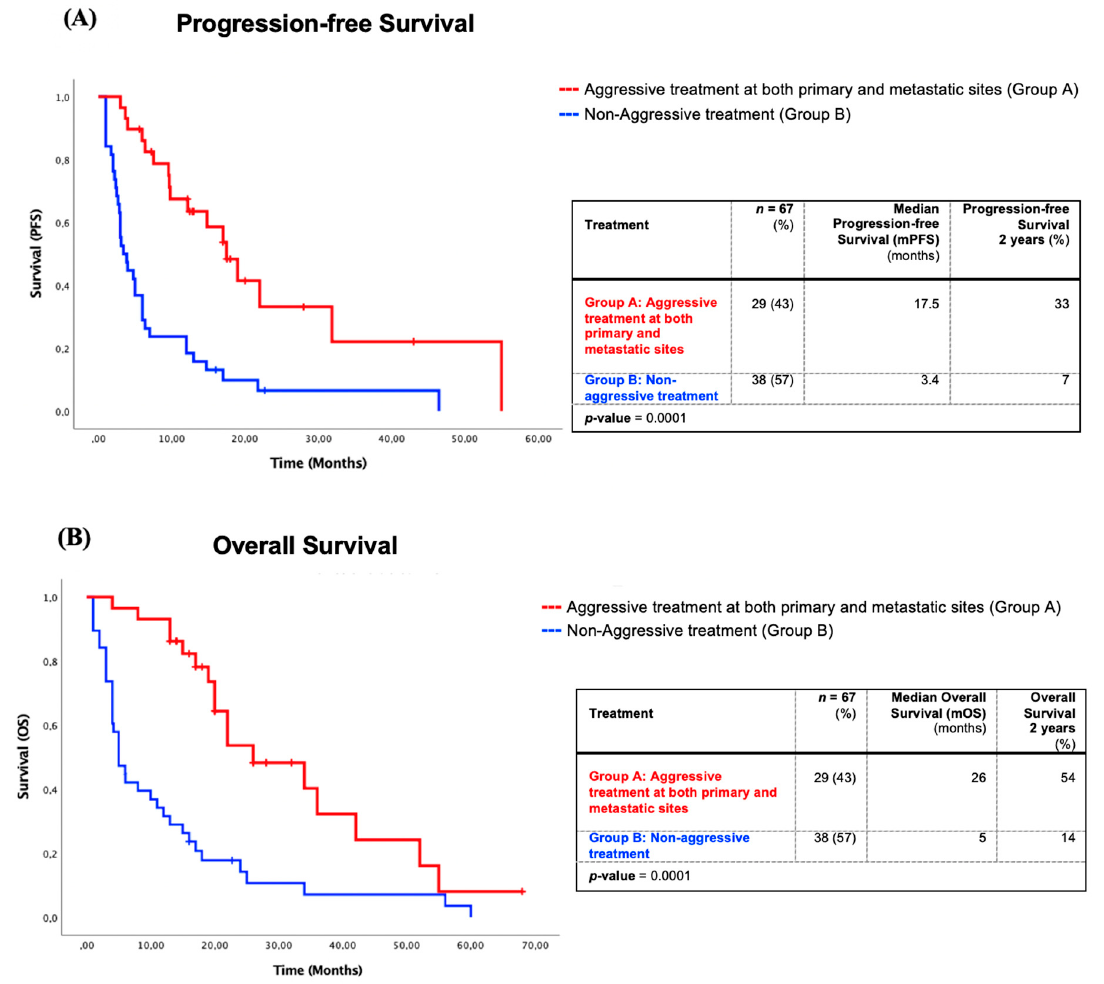
Figure 2. Survival of patients with aggressive treatments at both primary and metastatic sites (Group A) in comparison with non-aggressive treatments (Group B). ( A ) Kaplan–Meier progression-free survival analysis of patients with aggressive treatments at both primary and metastatic sites (Group A) in comparison with non-aggressive treatments (Group B). ( B ) Kaplan–Meier overall survival analysis of patients with aggressive treatments at both primary and metastatic sites (Group A) in comparison with non-aggressive treatments (Group B).